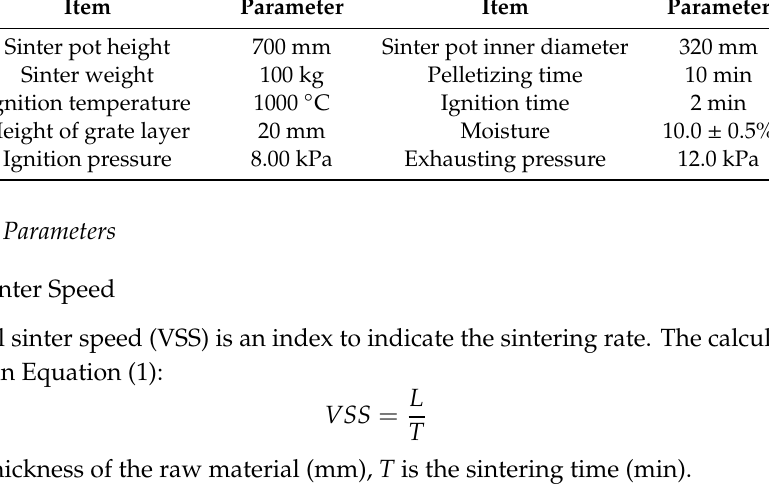
Table 3. Parameters of the high-chromium vanadium-titanium magnetite (HCVTM) sinter pot test. Item Parameter